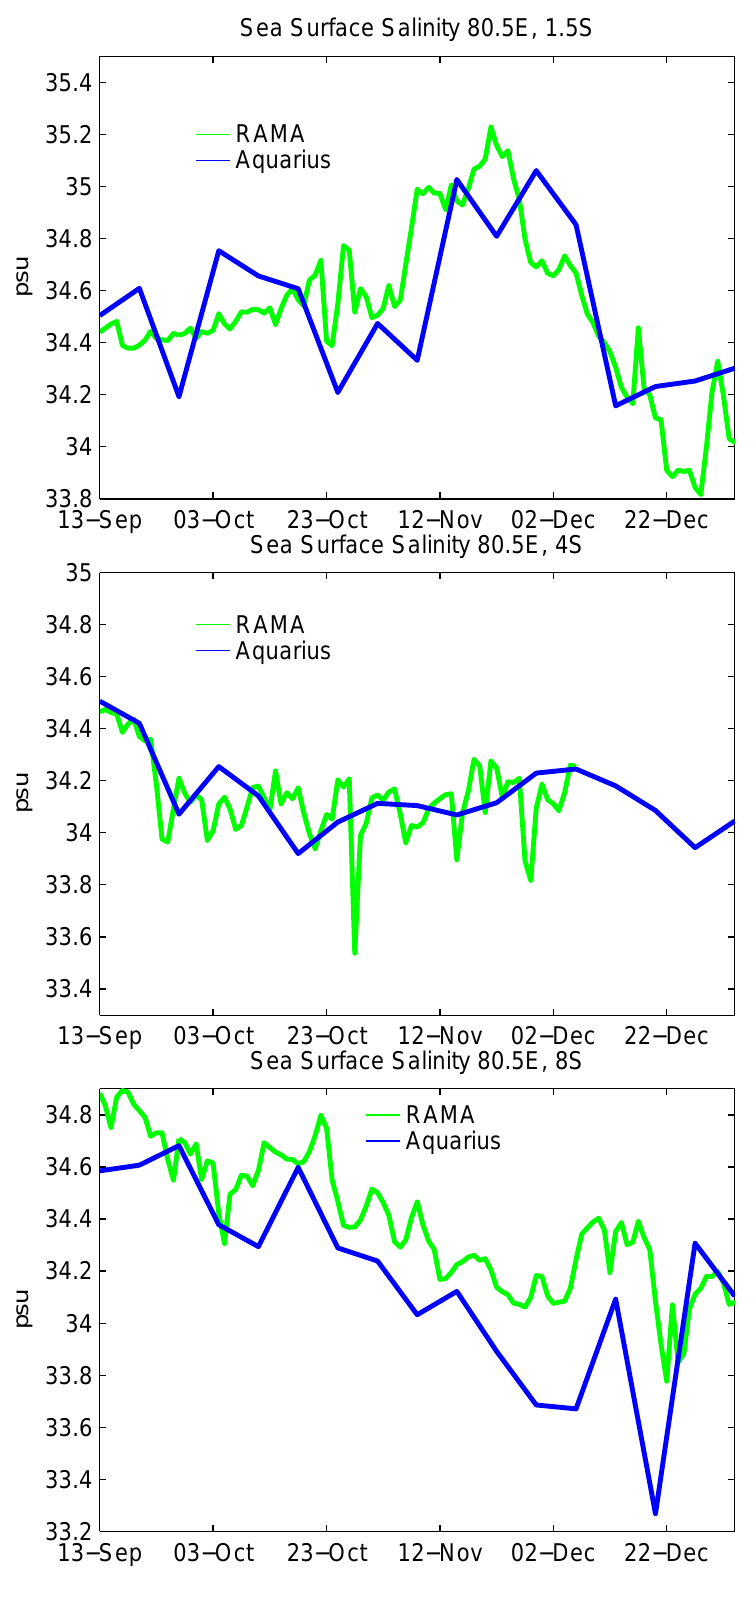
Figure 11. Time series of sea surface salinity (psu) in boreal fall 2011 estimated from Aquarius (blue line) and RAMA buoy (green line) at 80.5°E, 1.5°S ( top ), 80.5°E, 4°S ( middle ), and 80.5°E, 8°S ( bottom